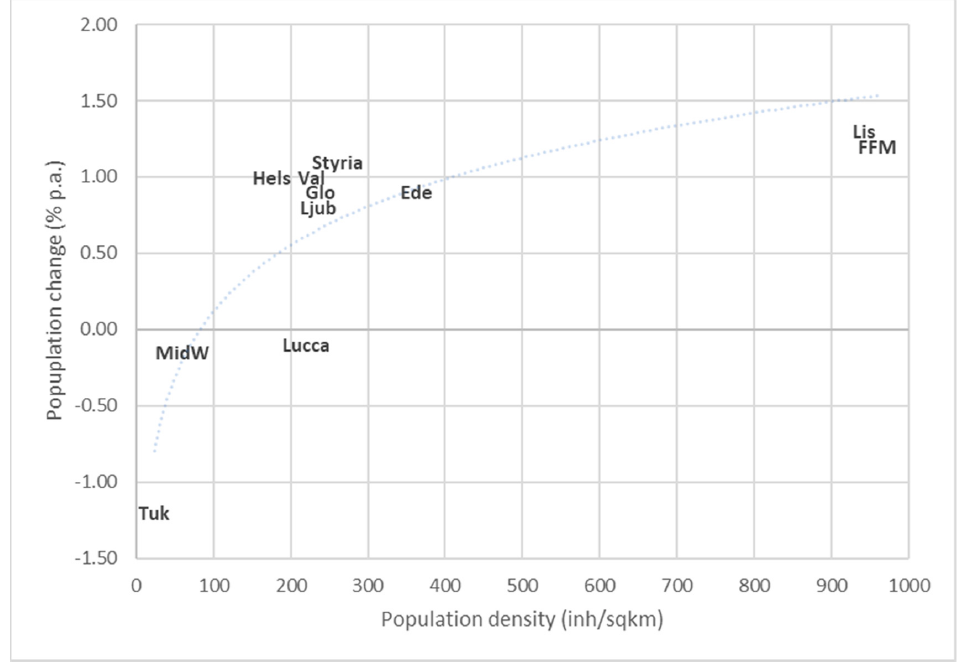
Figure A1. The 11 regions by population density and change.